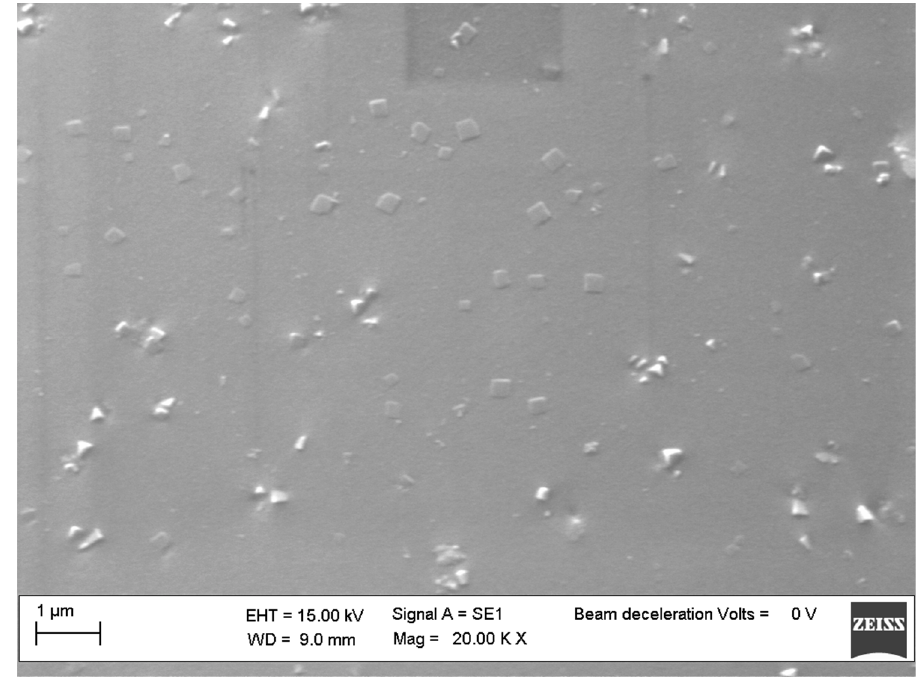
Figure 6. SEM images of PS/POSS 2 nanocomposites.